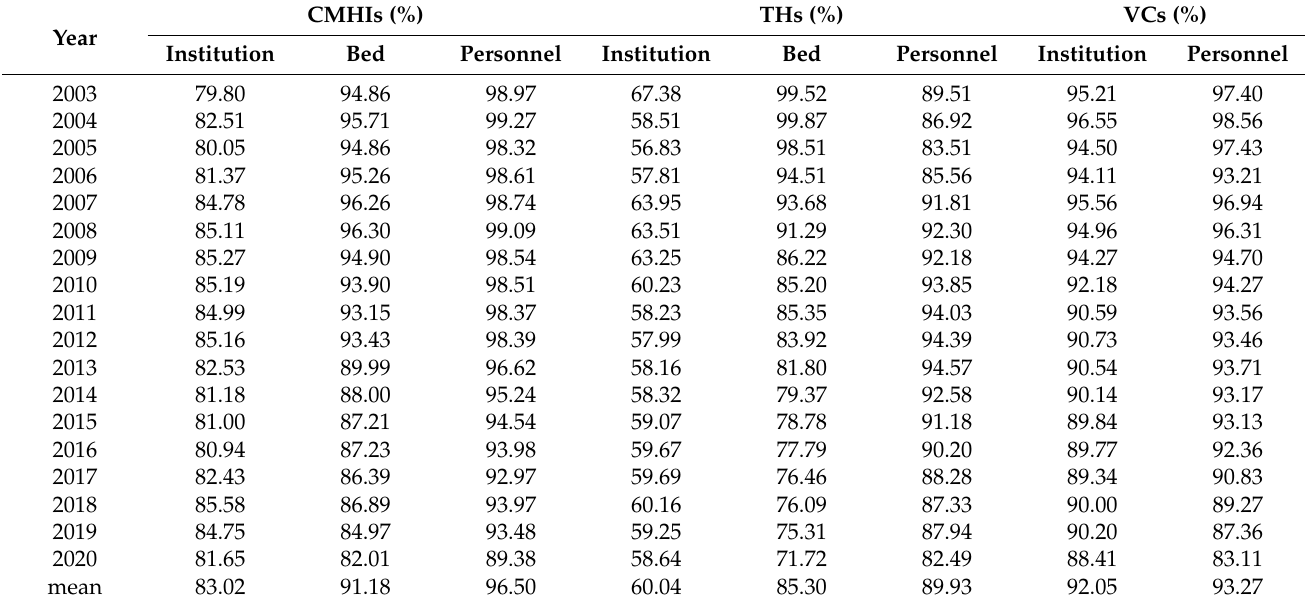
Figure 7. Changes in Theil index of health resource allocation from 2003 to 2020 (CMHIs: county and county-level city medical and health institutions; THs: township hospitals; VCs: village clinics). Table 1. Proportion of intra-group contribution differences of institutions, beds and personnel, based on China’s rural three-tier healthcare system (CMHIs: county and county-level city medical and health institutions; THs: township hospitals; VCs: village clinics). CMHIs (%) THs (%) VCs (%) Year